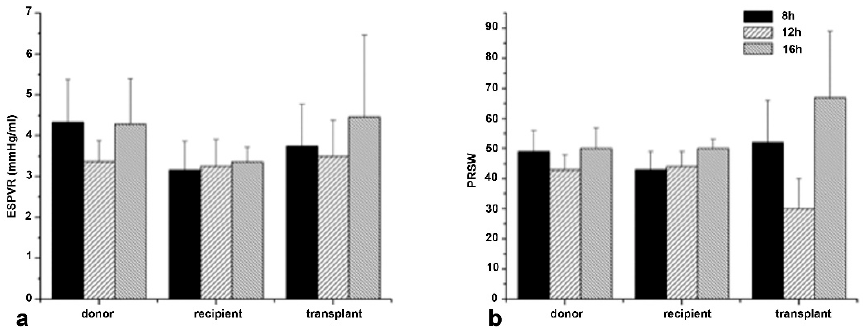
Figure 3. Hemodynamics (Series 2: long conservation time). ( a ): End-systolic pressure-volume relationships (ESPVR); ( b ): Preload recruitable stroke work (PRSW). n = 8 in each experimental group. Table 4. Hemodynamic variables before and 2 h after orthotopic transplantation (Series 2: long con- servation time).